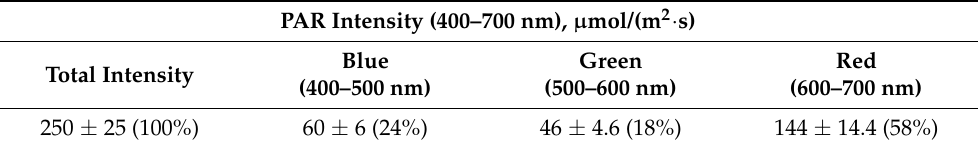
Table 1. Spectral distribution of illumination intensity in the PAR area.